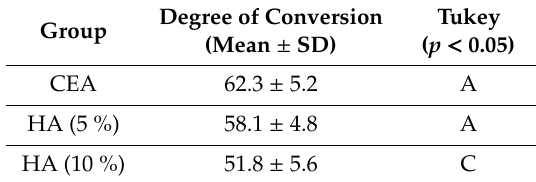
Table 2. Degree of conversion (%) of hydroxyapatite-modified experimental adhesives and control specimens. Degree of Conversion Group (Mean ± SD)